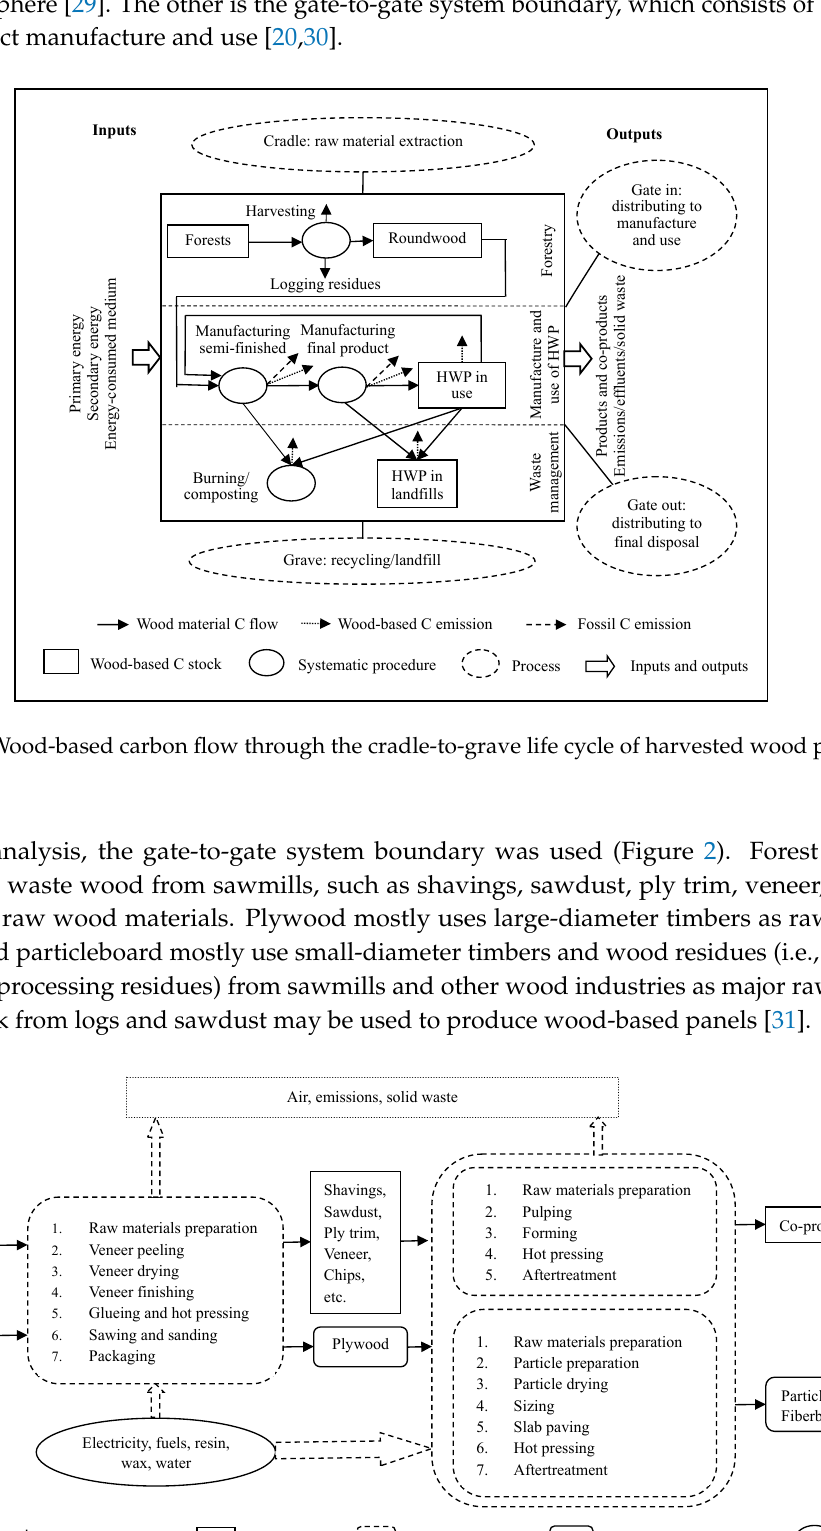
Fig 2. Gate-to-gate life cycle and process chain of wood-based panels. Figure 2. Gate-to-gate life cycle and process chain of wood-based